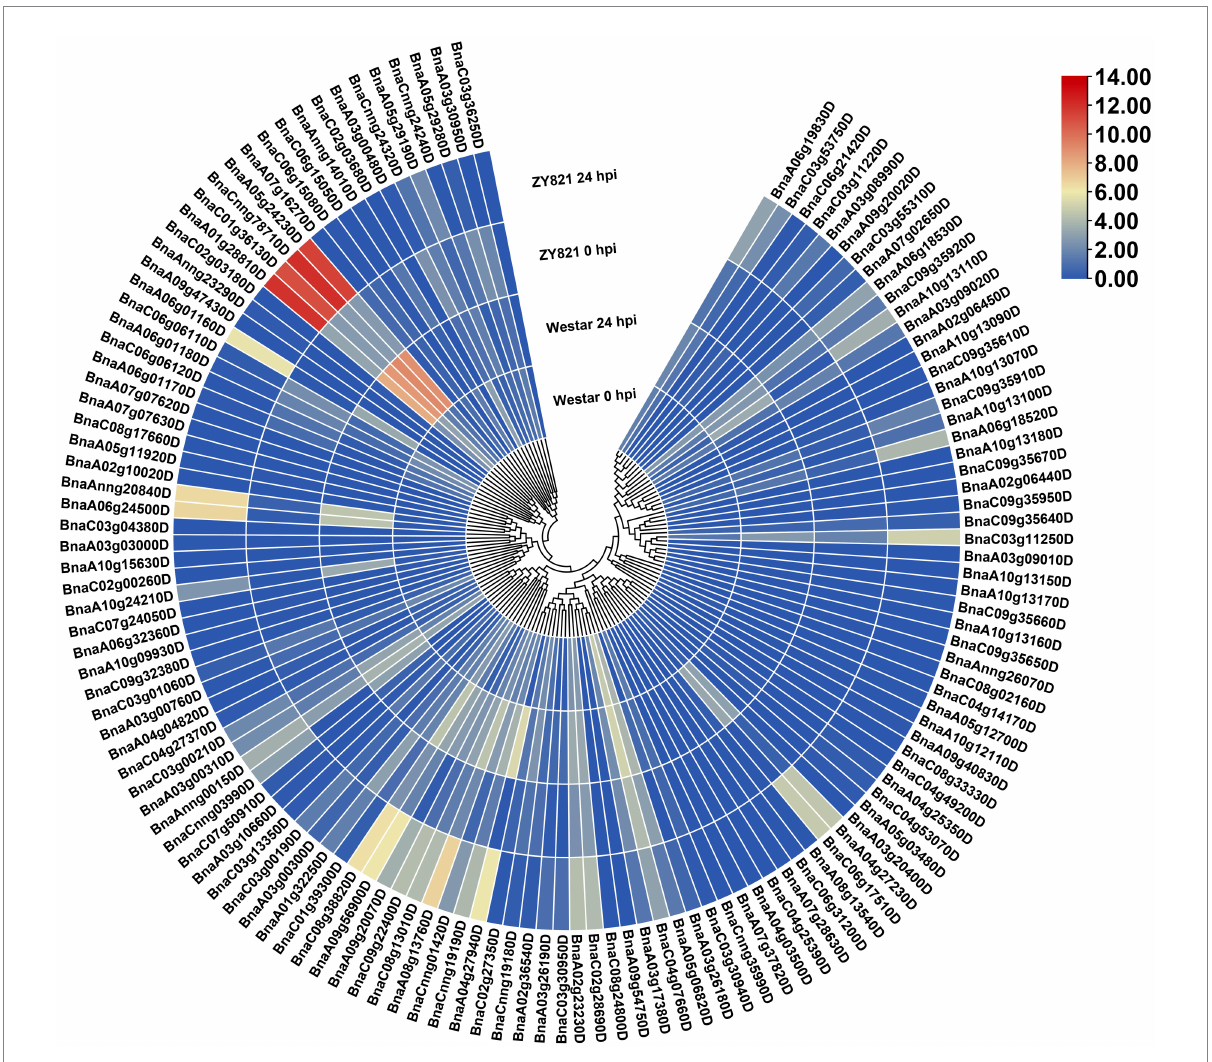
FIGURE 5 Expression patterns of the BnLegLu genes in Westar and ZY821 cultivars at 0 and 24 h after Sclerotinia sclerotiorum inoculation. The heatmap was generated by taking log2 fold of FPKM values. The color bar shows the relative expression from low (blue) to high